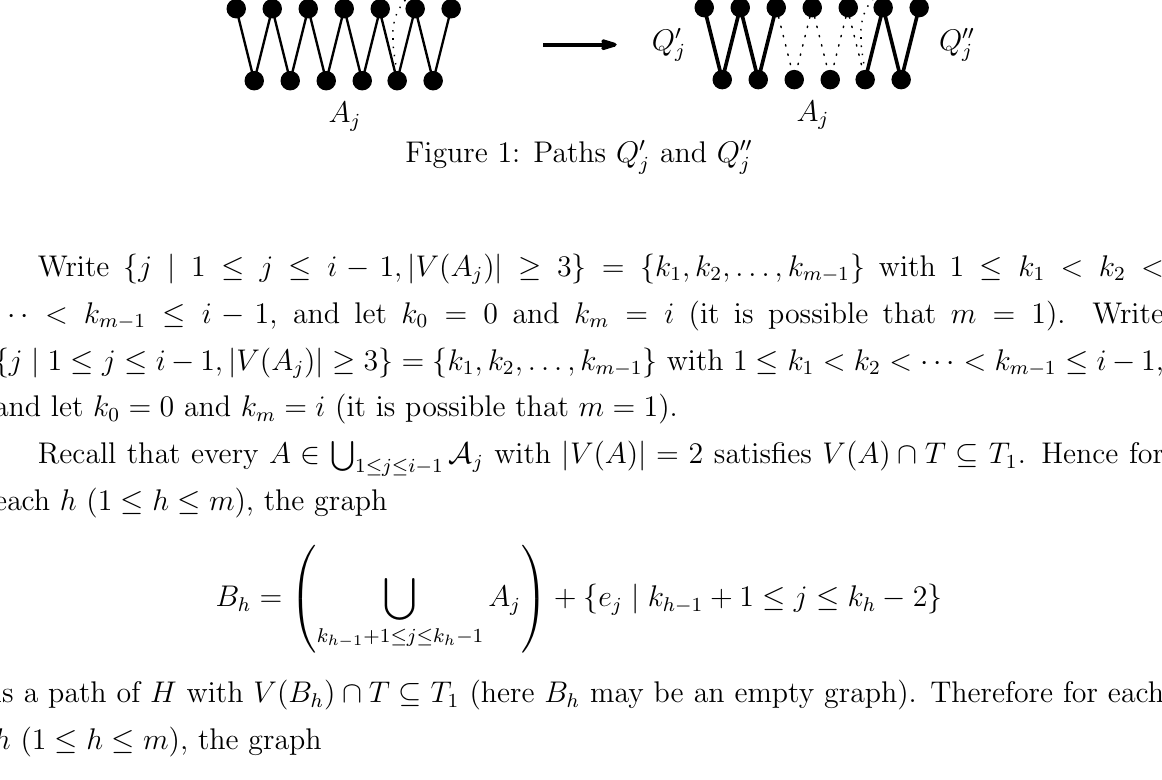
Figure 1: Paths Q ′